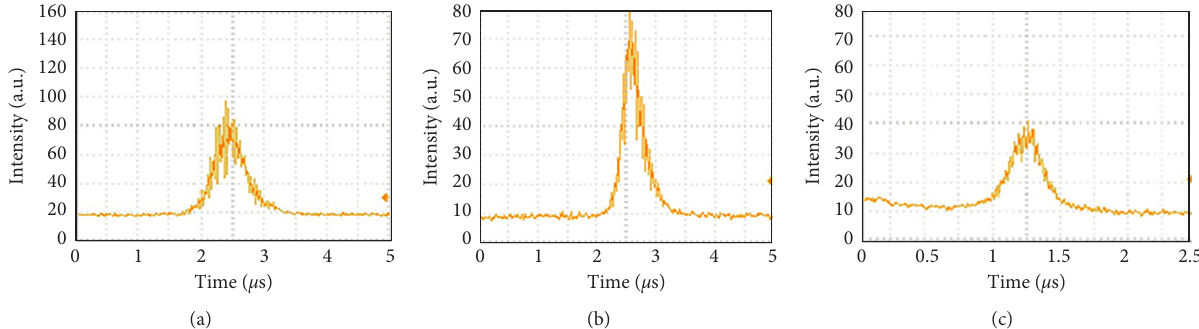
Figure 10: Measured temporal waveform of a single laser pulse when Cr 4+ :YAG T � 90% and when the electrical input energy is (a) 5.6J, (b) 6.0 J, and (c)